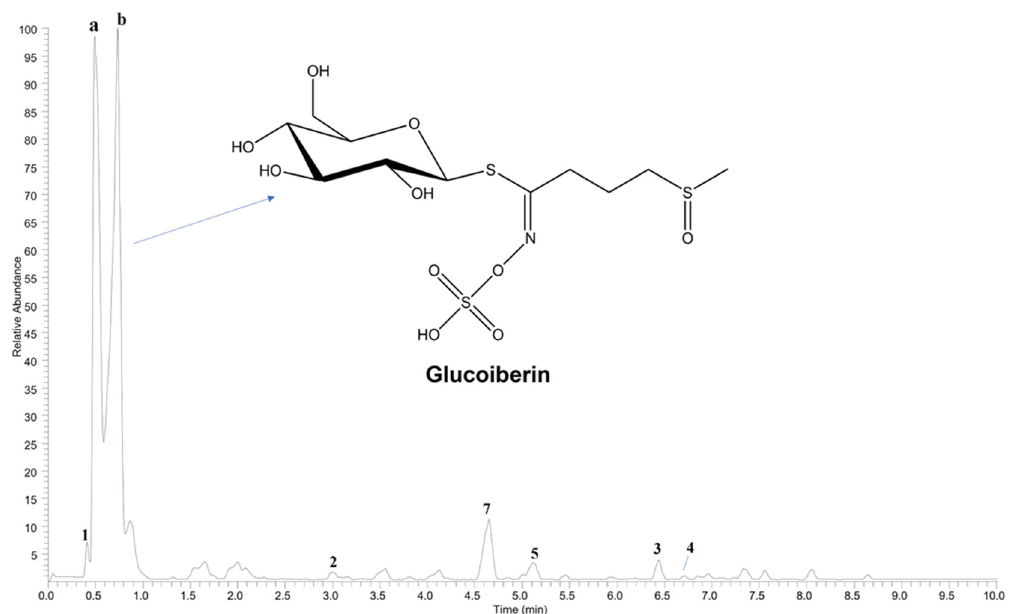
Figure 1. UHPLC-HR-MS profile of the aqueous fraction of Brassica drepanensis leaves, acquired in negative ion mode. 1 = phenylalanine; 2 = tryptophan; 3 = roseoside; 4 = sinapoyl glucoside; 5 = kaempferol 3- O -2”-sinapoylsophoroside-7- O - β - D -glucopyranoside; 7 = kaempferol 3- O - sophoroside-7- O - β - D -glucopyranoside; a and b = glucoiberin isomers.